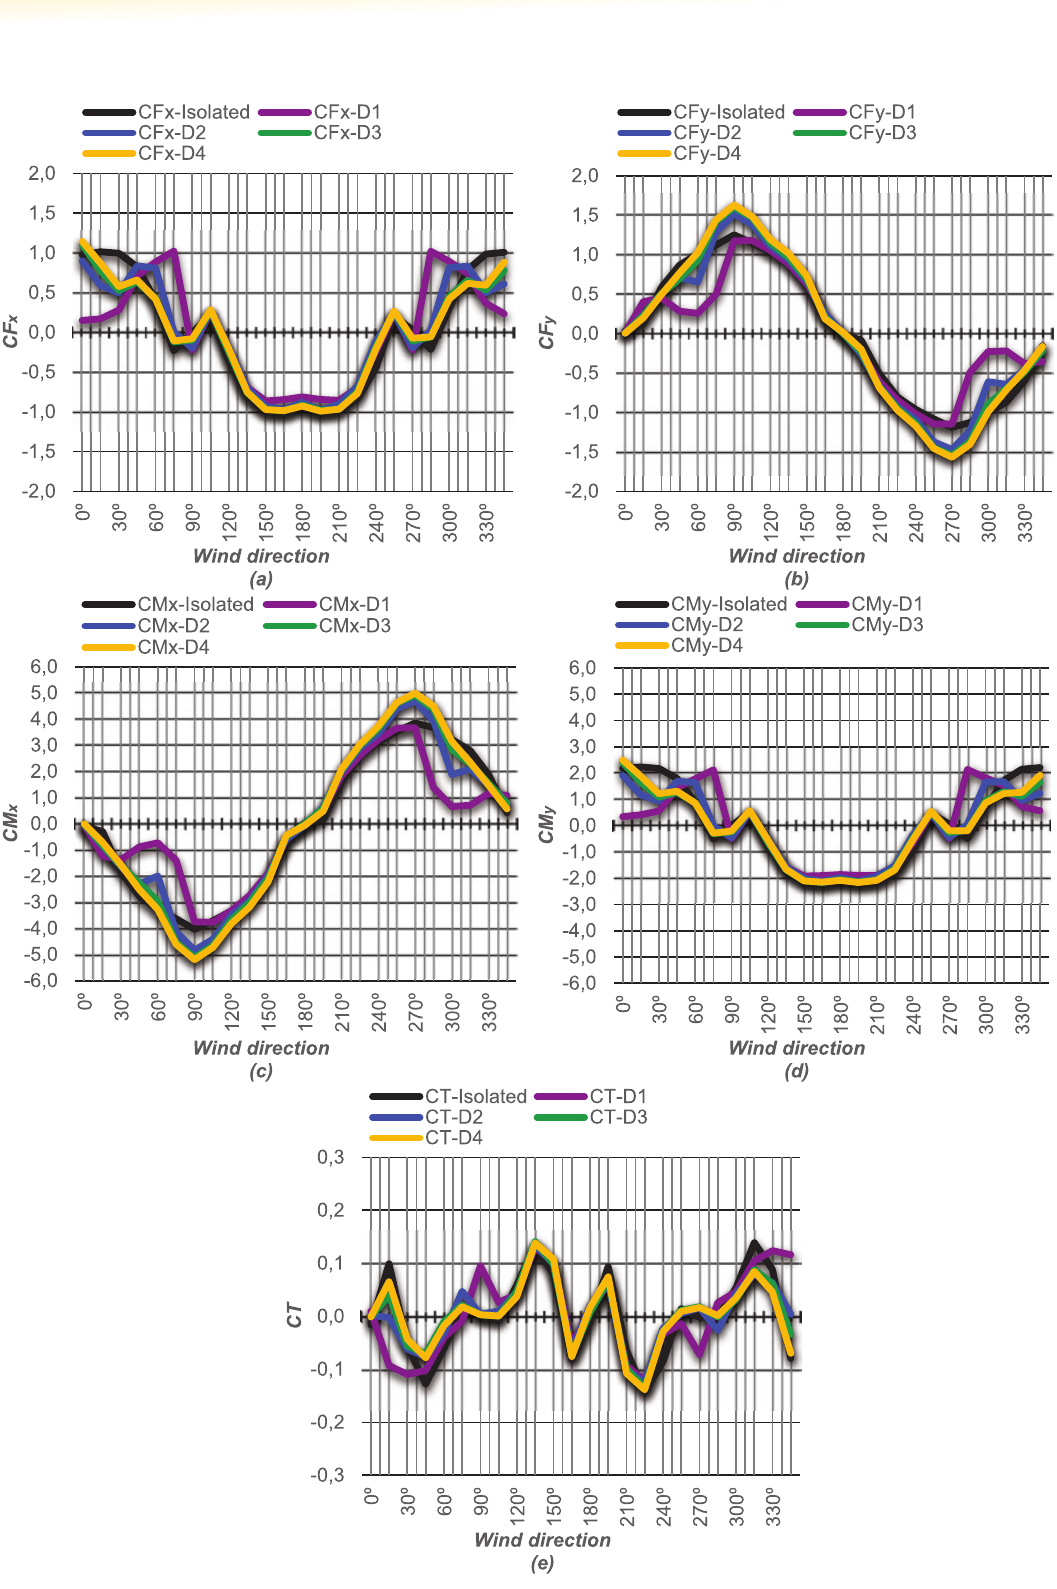
Load coefficients for the vicinity V8: (a) Resultant force in the direction of the X axis; (b) Resultant force in the direction of the Y axis; (c) Base momenta round axis X; (d) Base moment around axis Y; (e) Torsion around building